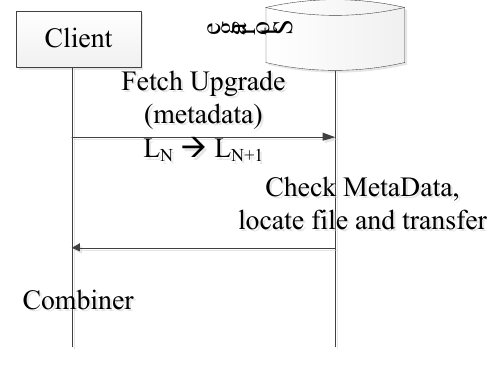
Figure 6. Mechanism for upgrading content